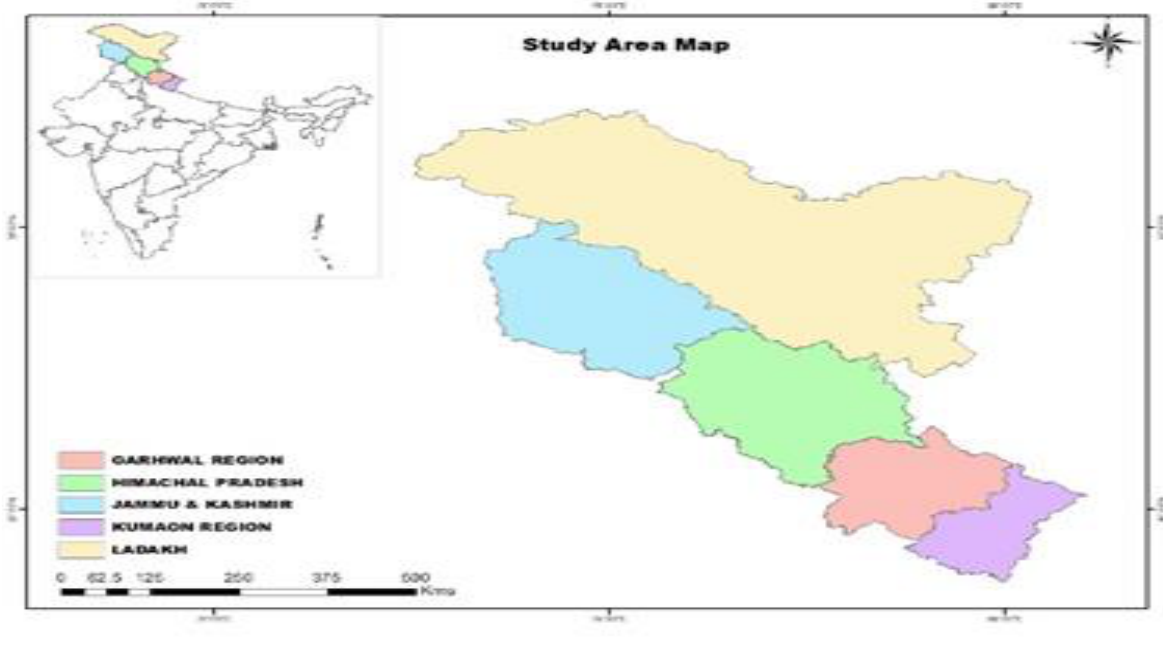
Figure 1. Study Area